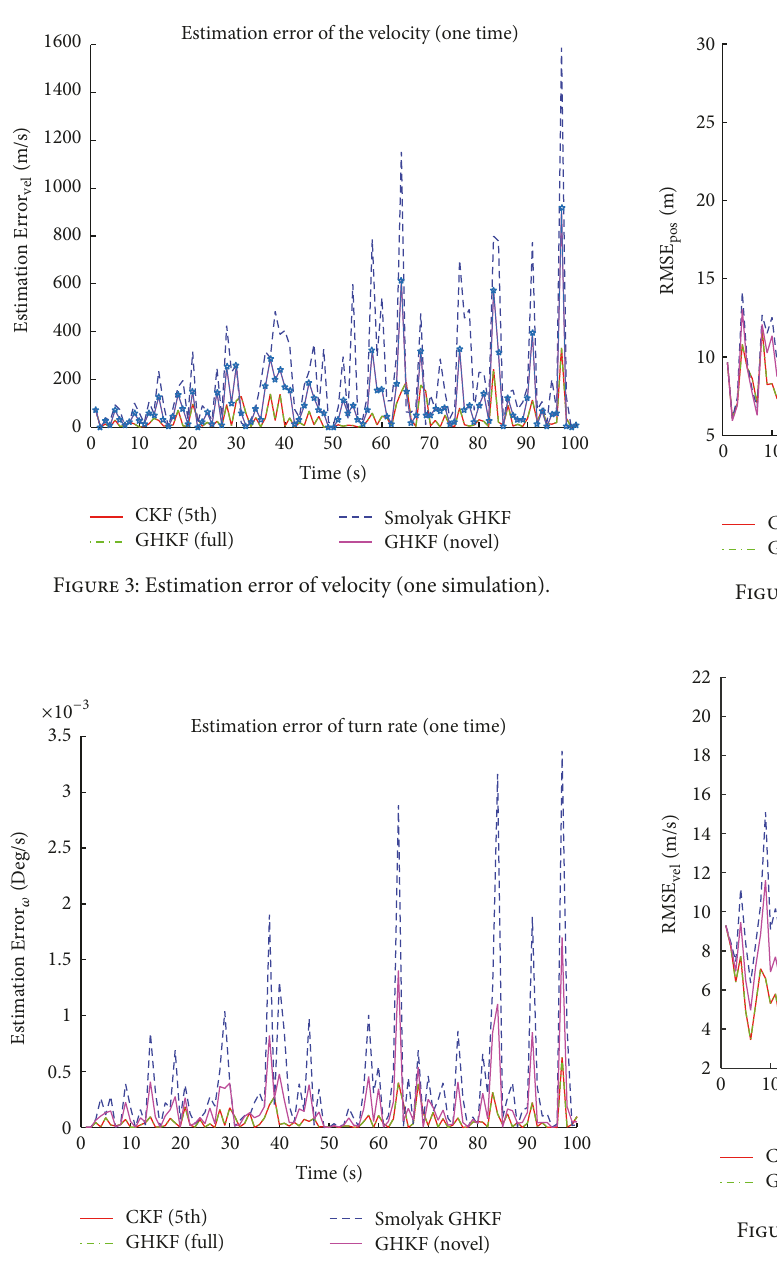
Figure 4: Estimation error of turn rate (one simulation).